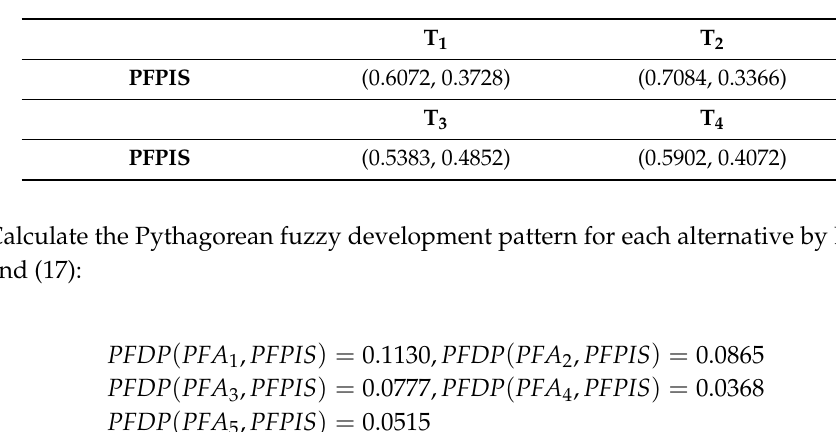
Table 13. Pythagorean fuzzy positive ideal solution (PFPIS).